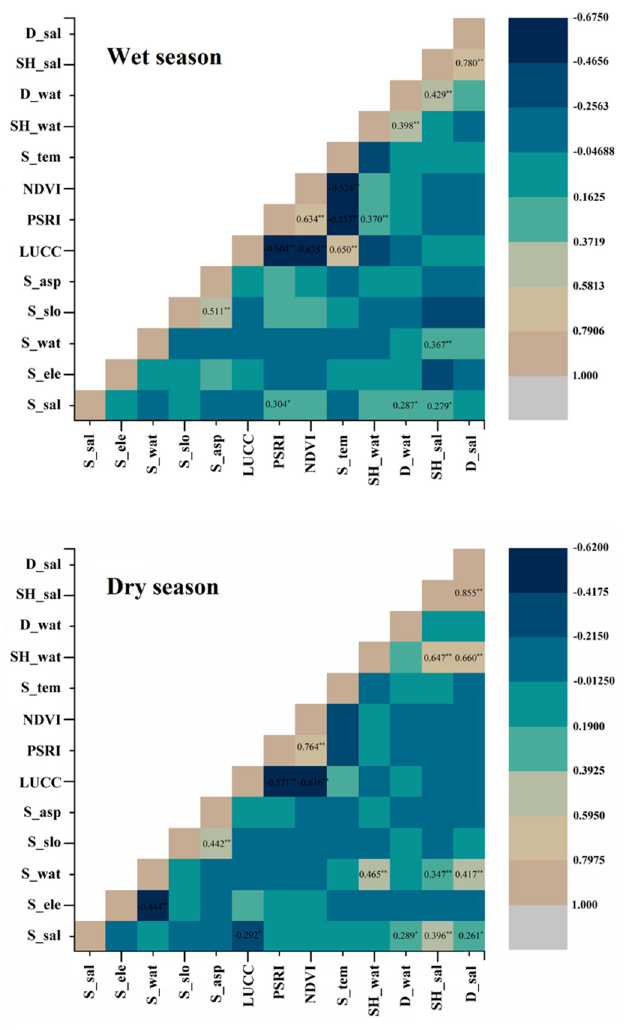
Figure 8. Correlation of salinization risk in wet season and dry seasons. * significantly correlated at the level of 0.05 (unilateral); ** significantly correlated at the level of 0.01 (unilateral). In the wet season, the high correlation between SH_sal and D_sal reached 0.780; NDVI and LUCC were the next highest at − 0.675; and LUCC and S_tem also reached 0.650. In the dry season, the correlation between SH_sal and D_sal was highest at 0.855; the correlation between PSRI and NDVI was next at 0.764; and the correlation between SH_sal and SH_wat also reached 0.647. Overall, the relevance of LUCC to NDVI was higher in both the dry and wet seasons, suggesting that, when land use patterns change, the vegetation cover changes accordingly. In addition, the D_sal and SH_sal correlations